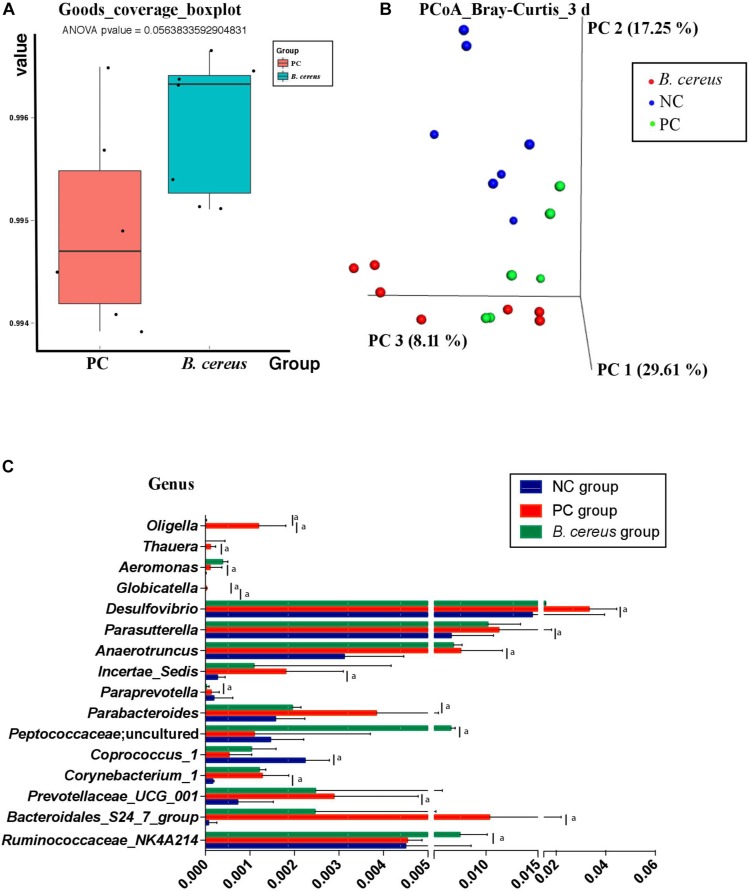
Effects of pretreatment with Bacillus cereus on the overall changes in the gut microbial community structure during D-GalN-induced acute liver injury. (A) The α-diversity of the gut microbiome determined based on the goods_coverage index of the probiotic group compared with the PC group. (B) The principal coordinate analysis (PCoA) plot shows the β-diversity of the gut microbiome with Bray–Curtis dissimilarity derived from 16S RNA sequencing data. (C) Comparison of taxa at the bacterial genus level between the PC and B. cereus groups. Data are presented as medians with first and third quartiles. (NC group, n = 7; PC group, n = 6; B. cereus group, n = 7). aP < 0.05 compared with the PC group. NC, negative control; PC, positive control; PCoA, principal coordinate analysis.